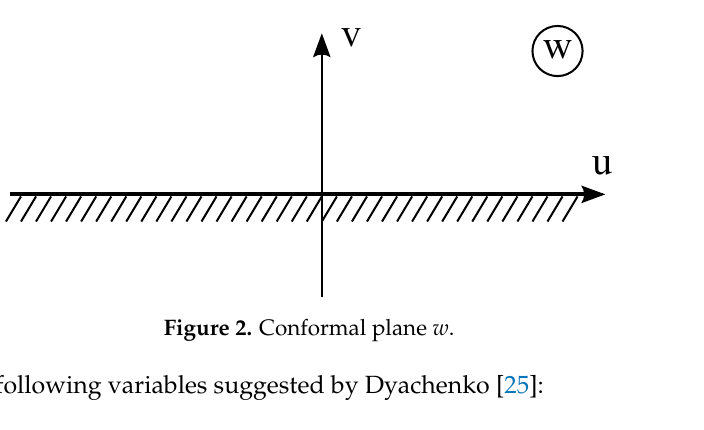
Figure 2. Conformal plane w